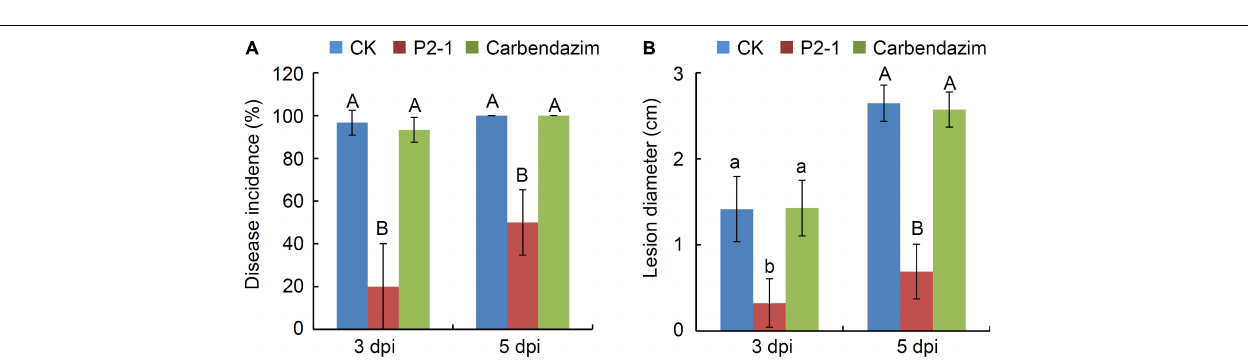
FIGURE 4 | Suppression of B. velezensis strain P2-1 supernatant on B . dothidea . (A) Inhibition of strain P2-1 supernatant on mycelial growth of B . dothidea . (B) Statistical analysis of colony diameter. (C) Inhibition rate of strain P2-1 supernatant on mycelial growth B . dothidea. (D) Effect of strain P2-1 supernatant on apple ring rot disease incidence. (E) Effect of strain P2-1 supernatant on apple ring rot disease lesion diameter. Each data represents the mean ± SD of three replicates. Letters above the bars indicate statistical significance and different letters indicate significant different means ( p < 0.05) based on Student’s t -test.